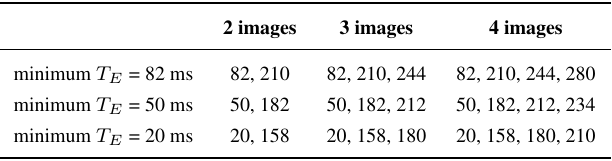
estimation of gray matter for acquisitions at 1.5 T in the 2 values. E